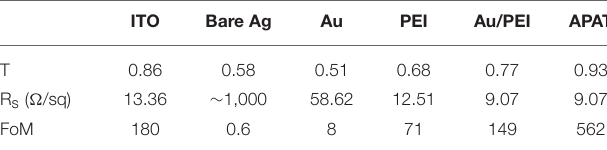
TABLE 2 | Optical and electrical parameters of transmittance, sheet resistance, and FoM obtained from different TCEs. ITO Bare Ag